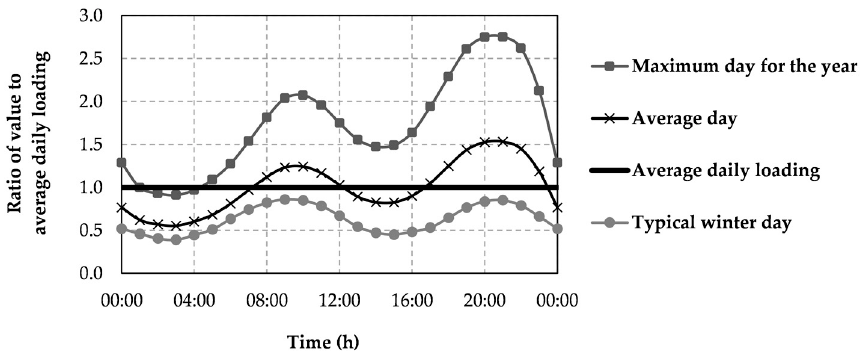
Figure 5. Typical hourly fluctuations regarding sewage loading that are assumed in the